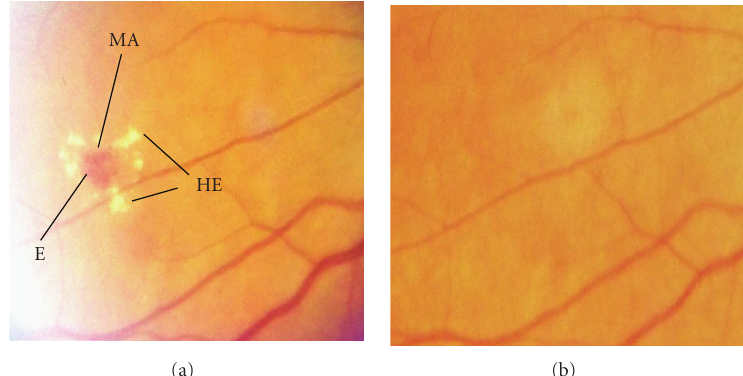
Figure 2: Fundus photographs showing pre-proliferative changes (a) at baseline in a patient who had a regression of eye lesions after three years of trandolapril therapy (b). This picture provides a comprehensive example of three typical lesions, microaneurysms (MA), hemorrages (E), and hard exudates (HE, that may regress in type 2 diabetic patients on ACE inhibitor therapy combined to intensified metabolic and blood pressure control, as in the BENEDICT